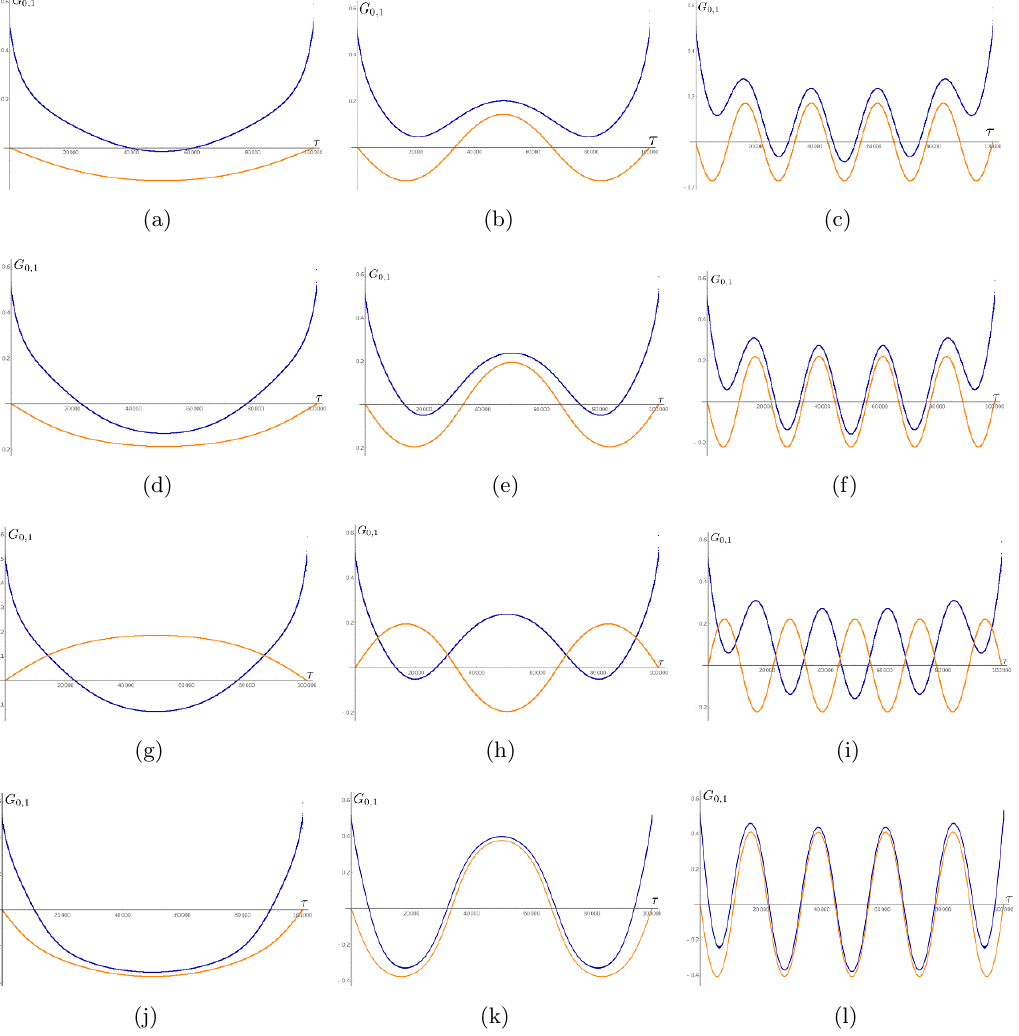
Figure 3 . G 0 (blue curve) and G 1 (orange curve) as a function of Euclidean time on replica- nondiagonal solutions for q = 4. The parameters are set at (cid:12) = 2 (cid:25) and J =